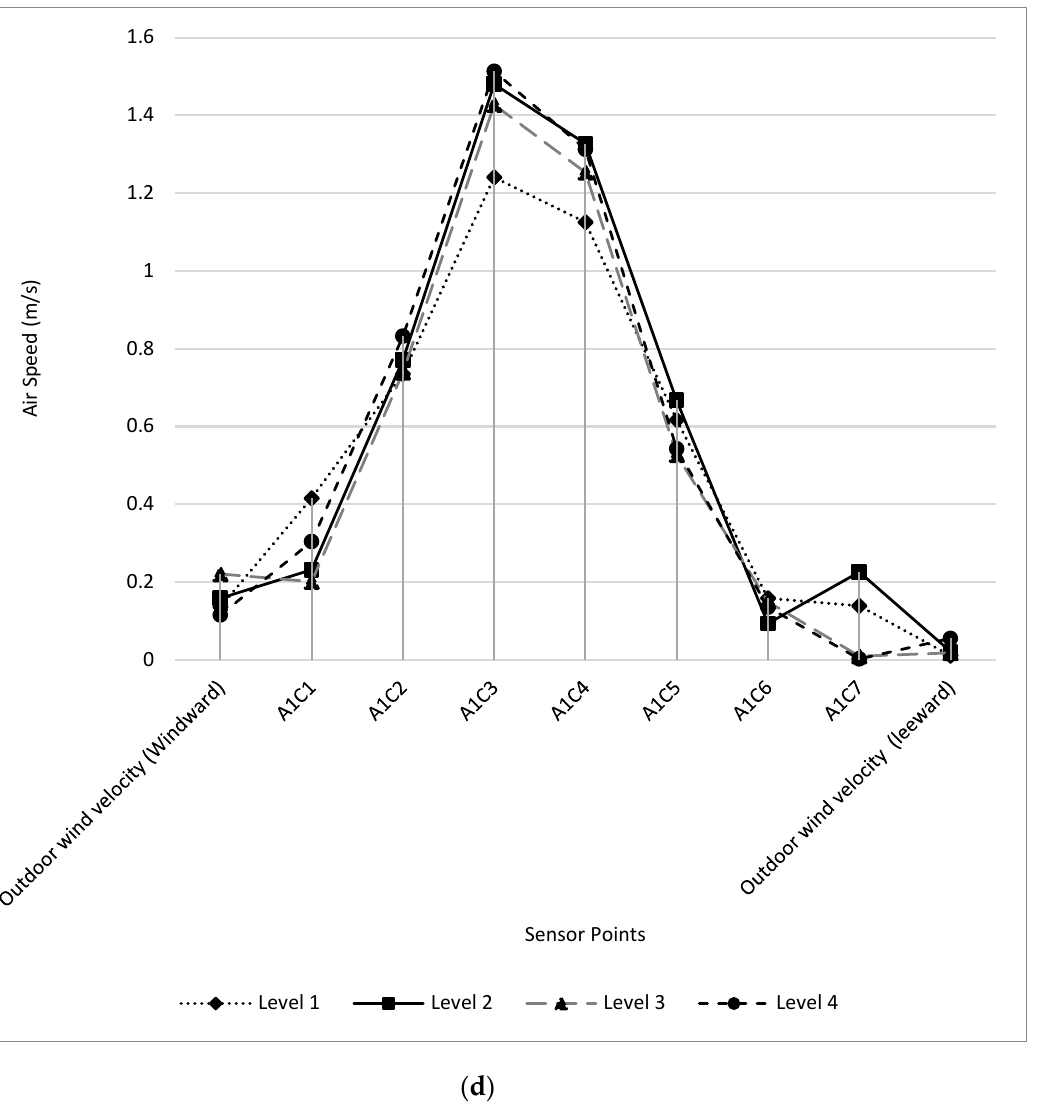
Figure 10. Simulation results for all 4 scenarios: ( a ) Scenario 1, ( b ) Scenario 2, ( c ) Scenario 3, ( d ) Scenario 4. Table 6. The mean and standard deviation in the air velocities measured across all 4 simulated